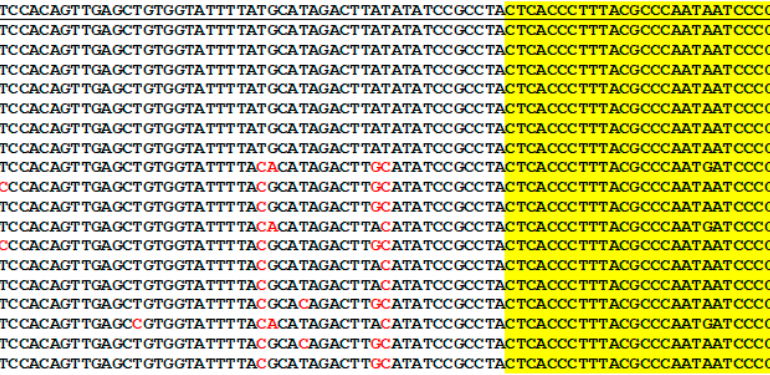
Figure 2. Alignment of the 282-base 16S rRNA gene DNA sequences defined by the Bg6 and Bg5 PCR primer sites (yellow-highlighted) with single nucleotide polymorphisms (in red) of various borrelial species. Sequences with ID# retrieved from the GenBank database listed at the beginning before the Bg6 primer site. The Bg6 primer is the reverse complement of the M1 primer, and this segment of borrelial 16S rRNA gene is an upstream extension of the M1 / M2 segment. Note: B. = Borrelia